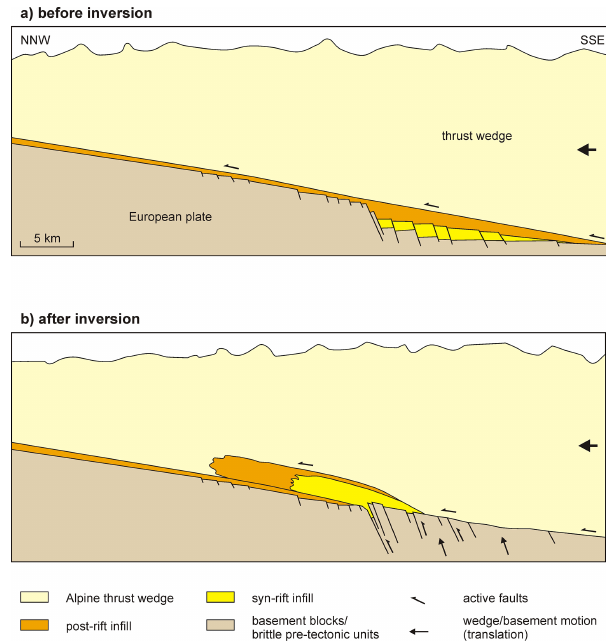
Figure 20. Inversion of the Doldenhorn Basin in the Swiss Alps, which was once a basin on the European passive margin of the Piemont–Ligurian Ocean, under a > 10km thick thrust wedge. The burial depth causes ductile rather than brittle behaviour during in- version. Modified after Musso Piantelli et al.